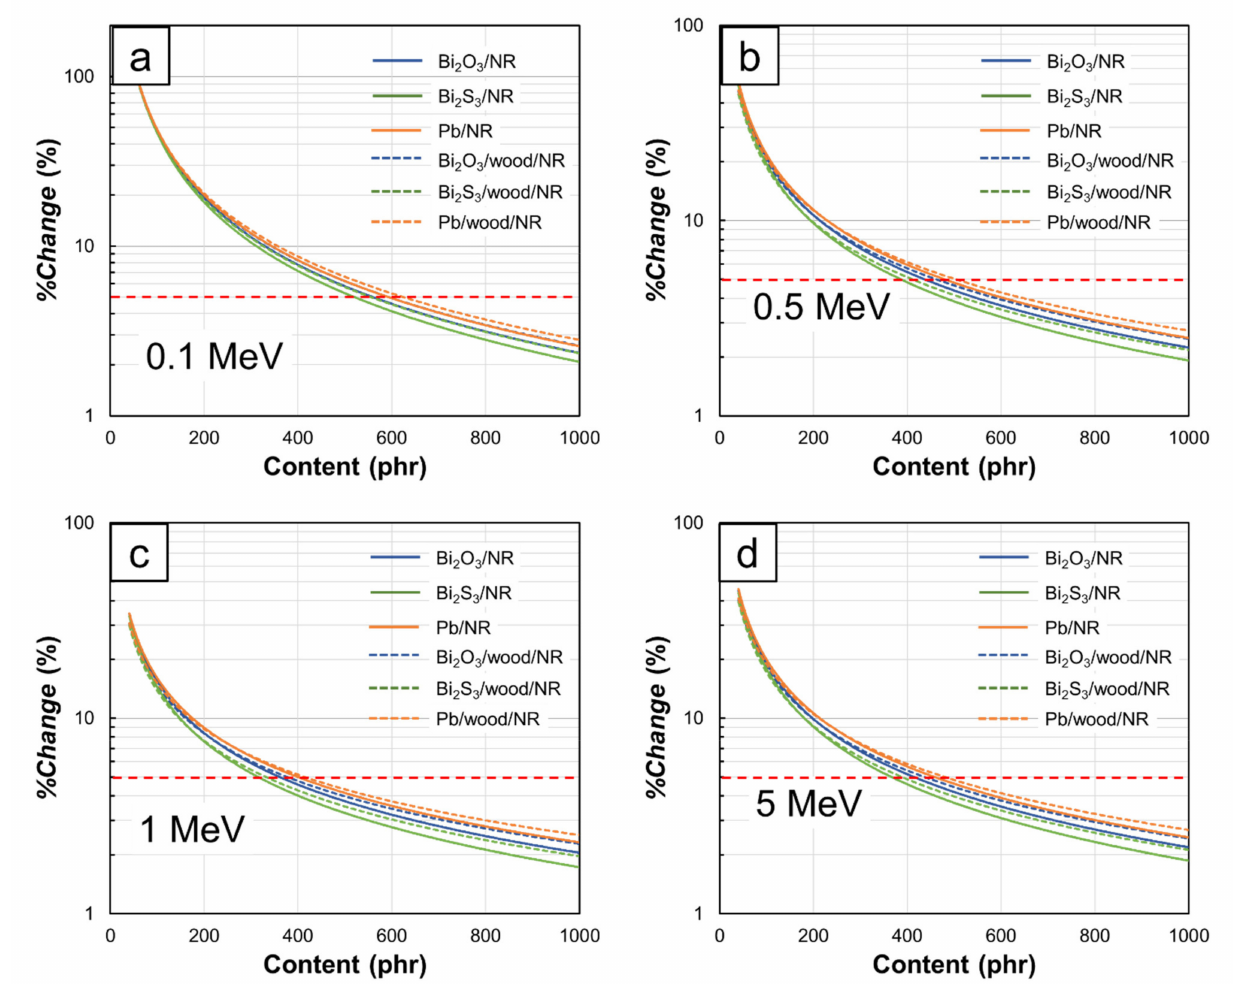
Figure 9. %change in µ values at photon energies of ( a ) 0.1 MeV, ( b ) 0.5 MeV, ( c ) 1 MeV, and ( d ) 5 MeV after addition of 40-phr Bi 2 O 3 , Bi 2 S 3 , or Pb into Bi 2 O 3 /NR, Bi 2 S 3 /NR, Pb/NR, Bi 2 O 3 /wood/NR, Bi 2 S 3 /wood/NR, and Pb/wood/NR composites. Horizontal dotted lines represent the threshold set in this work to determine recommended filler contents (% change <